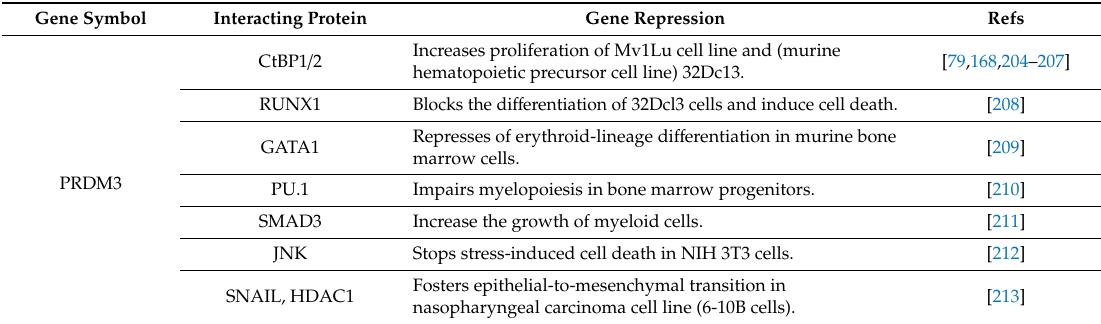
Table 3. Summary of PRDM3 / 16 and FOG1 / 2 interaction with their known cofactors. The PRDM3 / 16 and FOG1 / 2 proteins a ff ect the genetic program and cell functions by interaction with their cofactors. This influence may have a positive or negative e ff